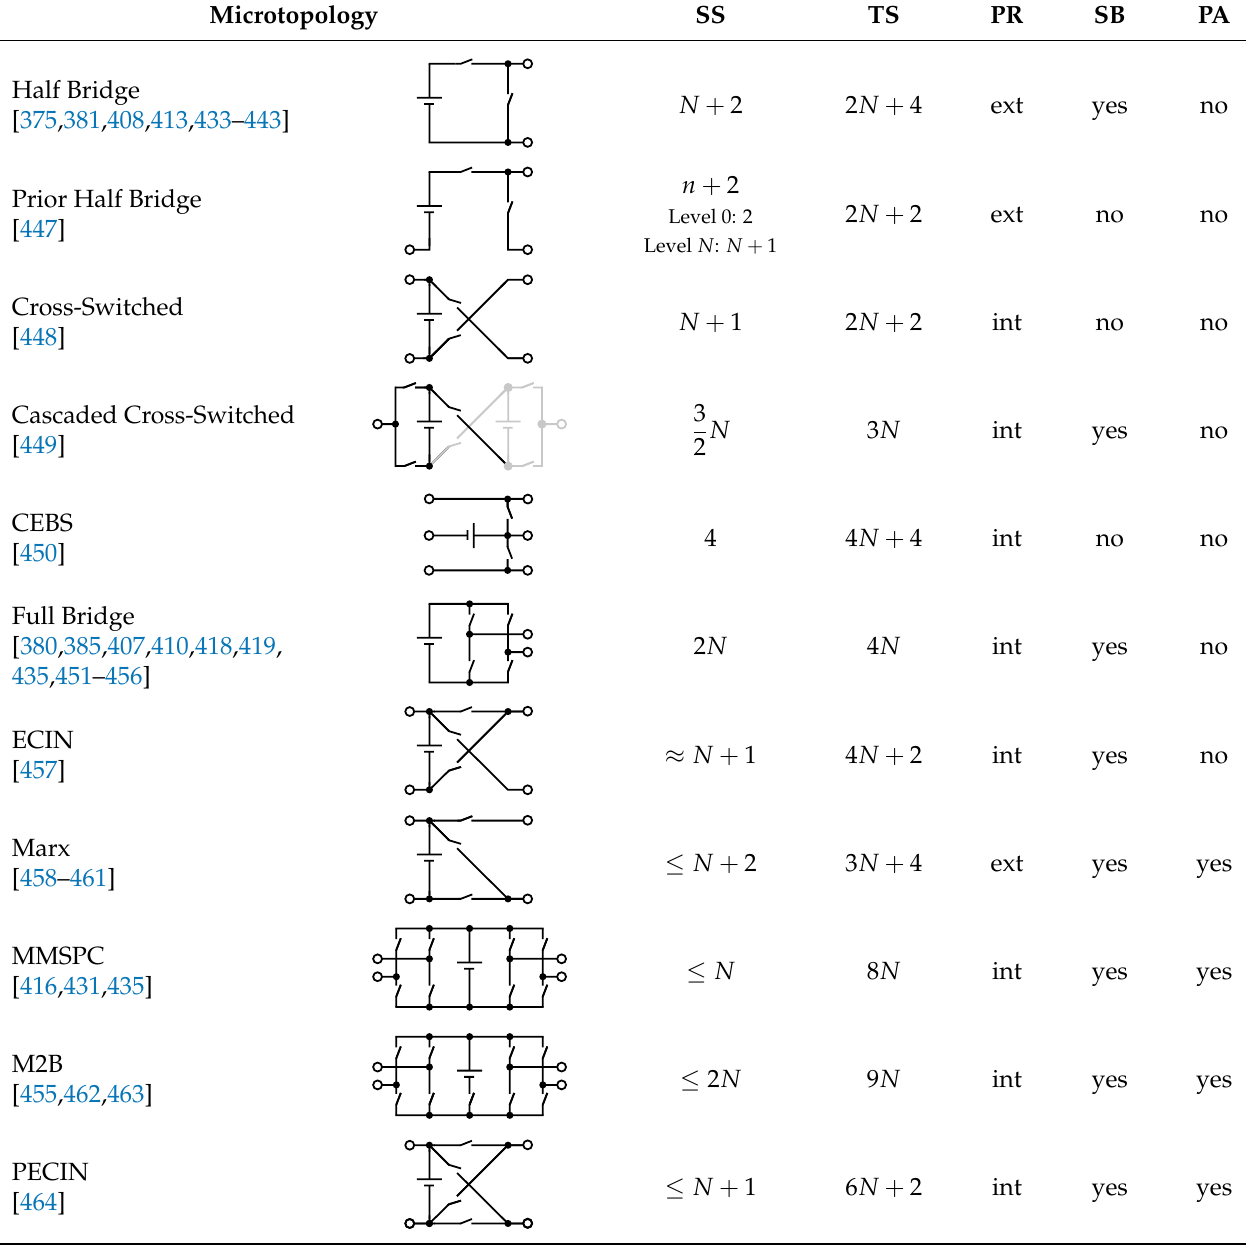
Table 7. Overview of microtopologies from the literature with the number of submodules N and the instantaneous output level n . All associated macrotopologies achieve the full 2 N + 1 output levels but may need a polarity reversal circuit to do so. The number of switches is counted with respect to the macrotopology, which includes the potential polarity reversal circuit. Abbreviations: serial switches (SS), total switches (TS), polarity reversal (PR), serial bypass (SB), parallelization (PA), external (ext), internal (int), Common Emitter Bidirectional Switched Based MLI